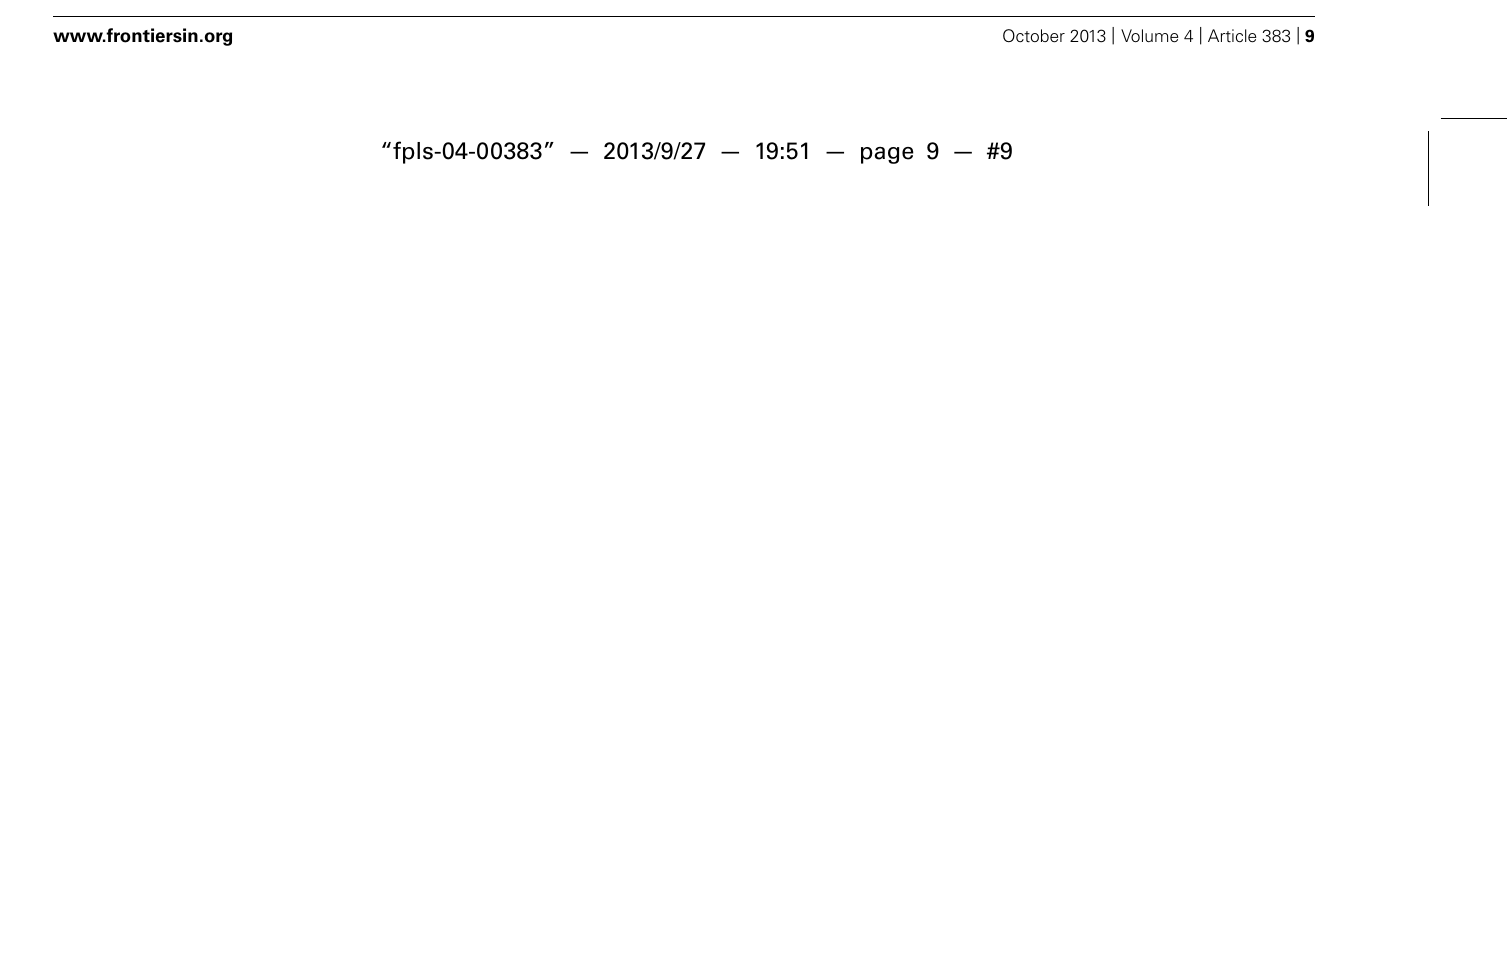
ProOsSWN1:OsSWN2S-SRDX rice plants. (I, J) Cell wall sugar composition of TFA soluble fraction (I) and TFA insoluble fraction (J) in alcohol insoluble residues (AIR). Sugar composition was analyzed in AIR of ProOsSWN1:GU S [control (black, n = 5)] and ProOsSWN1: OsSWN2S-SRDX (white, n = 11). “*” and “**” indicate P value of Welch’s t -test < 0.05 or 0.01, respectively. Error bars indicate SD in (G, H, K–M) , SE in (I) and (J) . Bars represent 10 cm in (A) and (B) , 50 μ m in (C) and (D) , 5 μ m in (E) and (F)